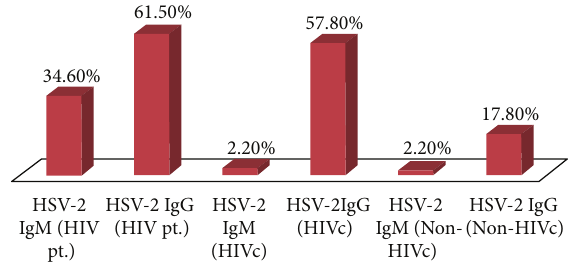
Figure 2: Prevalence of HSV-2 IgM and IgG in HIV pt., HIVc, and non-HIVc